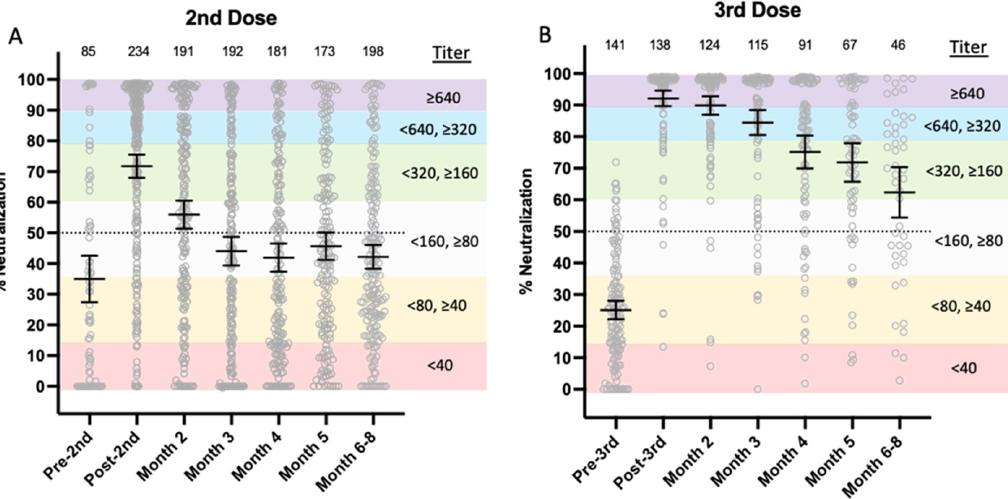
Figure 2. Overall comparison of second- and third-dose COVID-19 mRNA vaccine-induced NAb durability. ( A ) Second dose; ( B ) third dose. Gray circles represent percent neutralization from each study participant vaccinated with either BNT162b2 or mRNA-1273 within one week prior to vaccination (Pre-2nd), 2–4 weeks postvaccination (Post-2nd), then monthly after either second or third doses. The horizontal black lines with error bars represent mean with 95% confidence intervals. Dotted line is 50% neutralization. Numbers above each x-axis time point indicate the number of participants. Reciprocal titer ranges corresponding to % neutralization are shown on the graphs as shaded purple ( ≥ 1:640), blue (<1:640, ≥ 1:320), green (<1:320, >1:160), light grey (<1:160, ≥ 1:80), orange (<1:80, ≥ 1:40), and red (<1:40) as reported in [18]. Percent neutralization was calculated as 1-(test line density/limit of detection) x100% (limit of detection test line density = 942,481), as detailed previously